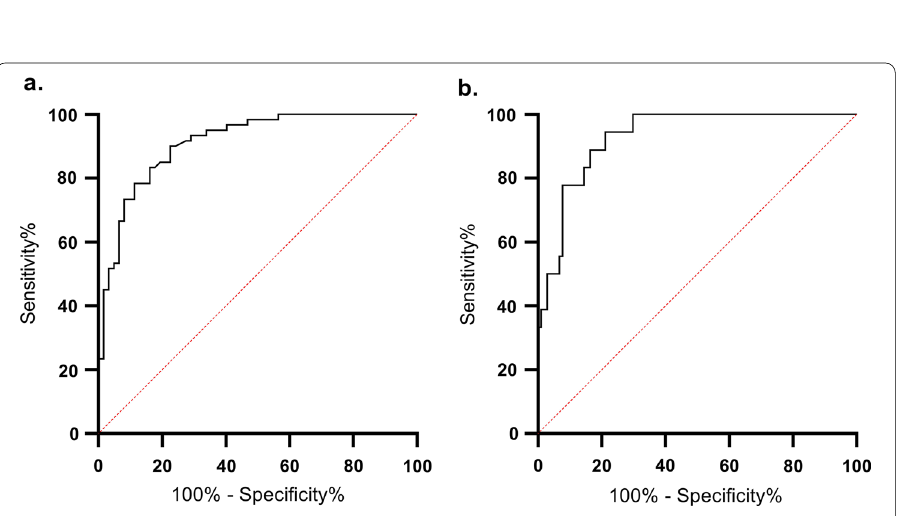
green dotted striped line and LoA red = =